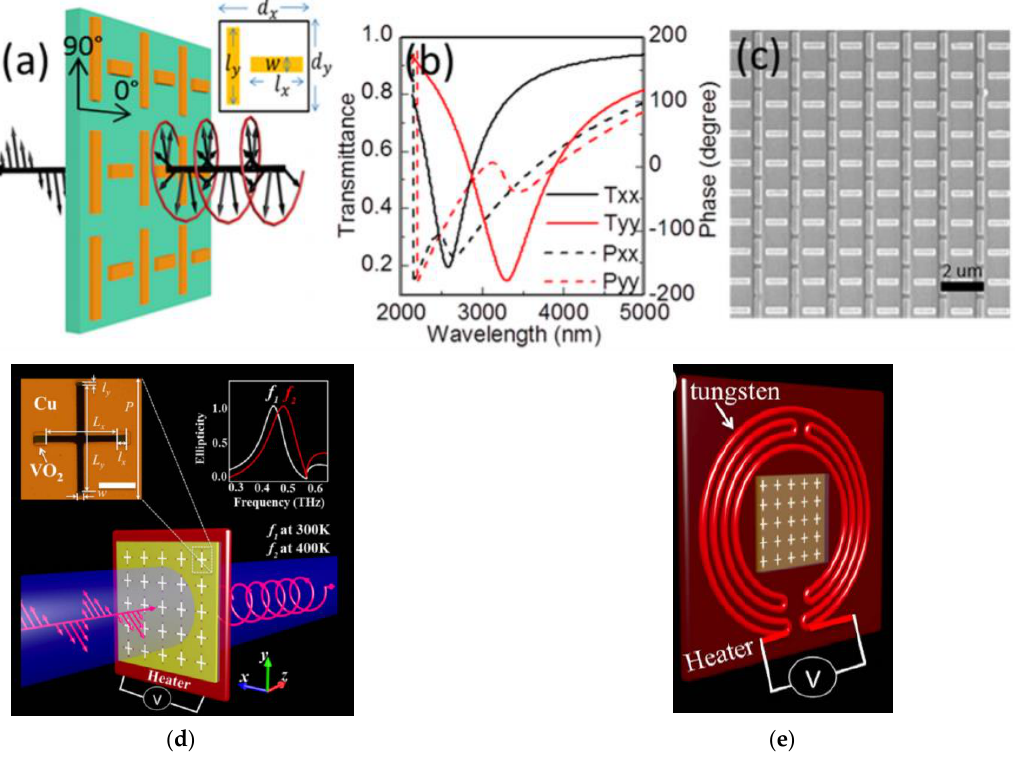
Figure 9. ( a ) Schematic of the design of MS as polarization converter in mid-infrared region. ( b ) Full-wave simulations of the transmittance (solid curve) and phase (dashed curve) for the MS; ( c ) SEM image of a nanoimprinted MS [110]; ( d ) experimental schematic for frequency switchable of the THz LP-to-CP converter; ( e ) schematic backside view of the resistive heater with a square aperture (6 × 6 mm 2 ) milled at the center to allow THz to pass through [111].